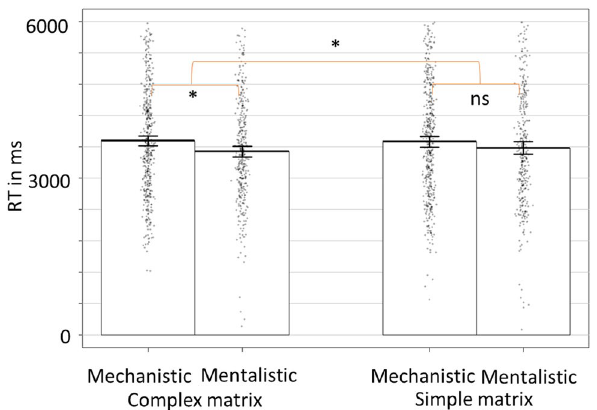
Figure 6. Time to select mechanistic and mentalistic descriptions as a function of the cognitive load level induced by the complex vs simple matrices. * = p < 0.050; ** = p < 0.010. The RTs correspond to the time of response after the activation of the responses keys (or 3000 ms after the display of the